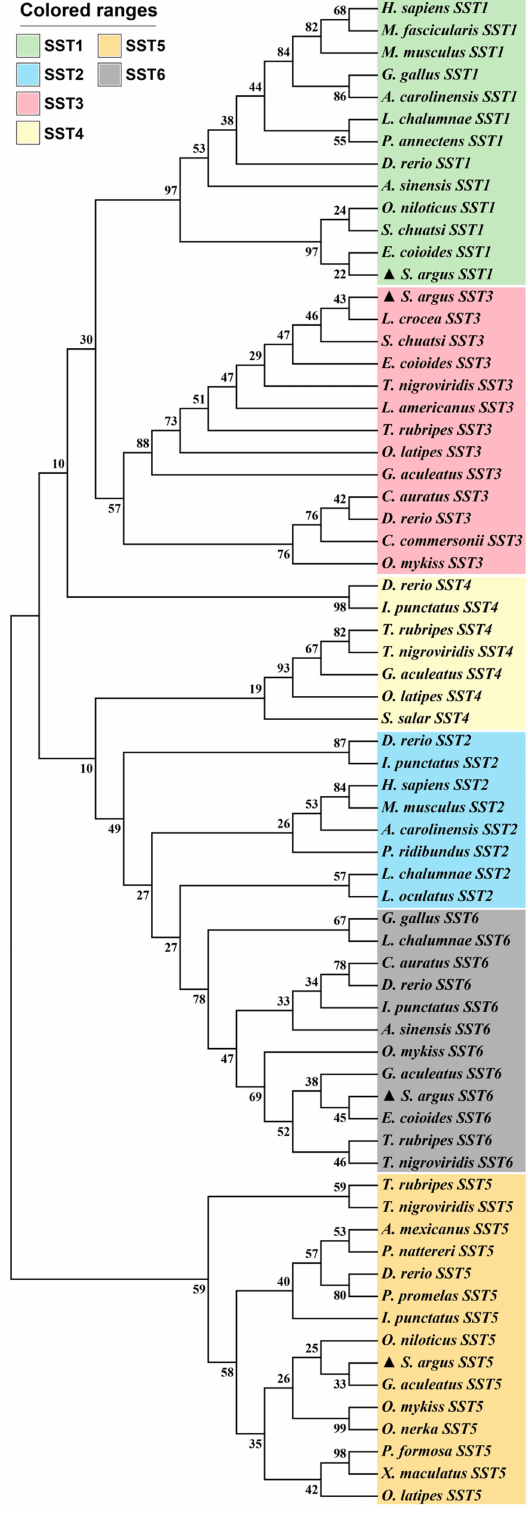
Figure 2. Phylogenetic tree of the SST family members in selected vertebrate species. The tree was constructed using mega 7.0 and the maximum likelihood approach. Bootstrap testing was based on 500 replicates. The SST genes of S. argus are denoted by triangles. Genbank accession numbers of these genes are provided in Table